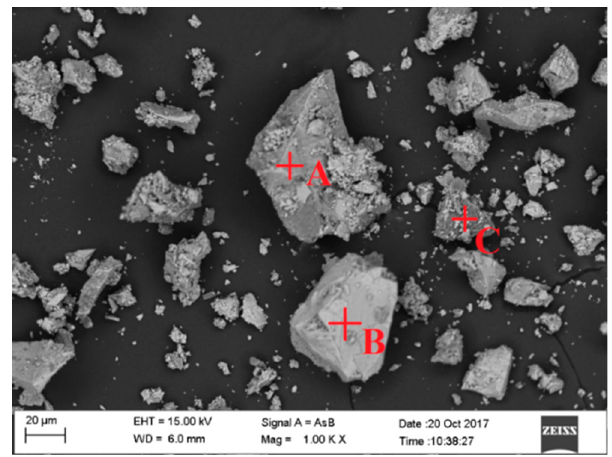
Figure 1. Micrographs of typical HCVTM particles. Table 3. Elemental composition of grain mark in Figure 1 (wt %).